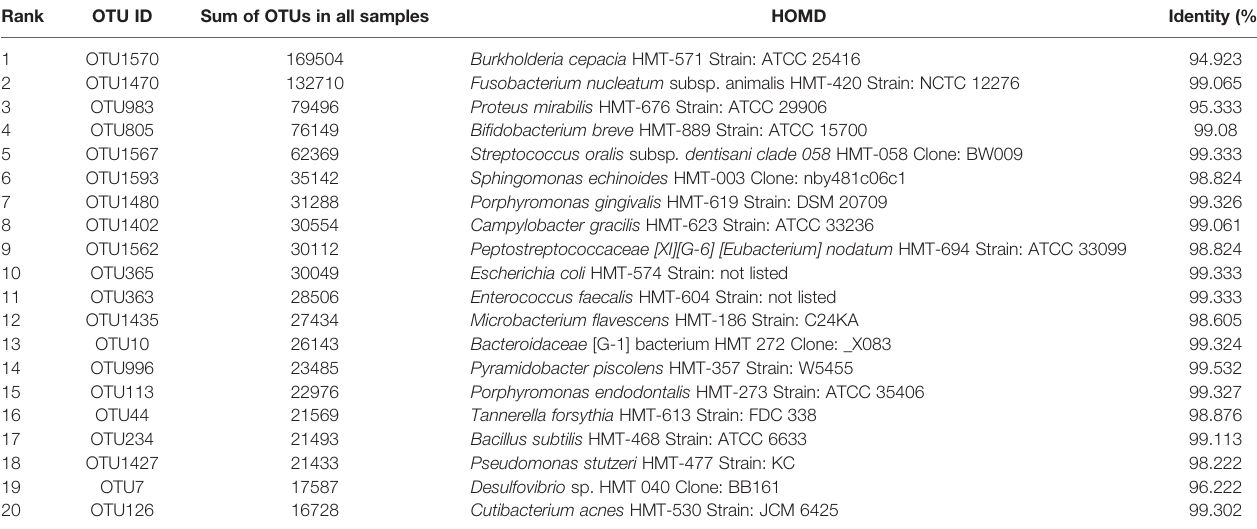
TABLE 2 | Top OTUs classi fi ed against the HOMD database.